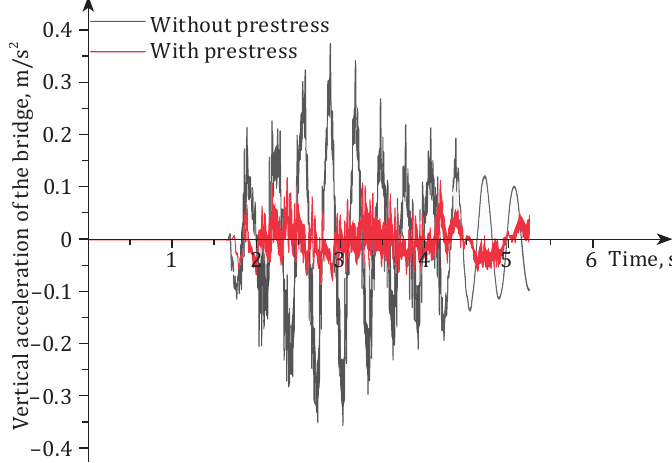
Figure 13. Comparison of vertical displacement time history at bridge midspan